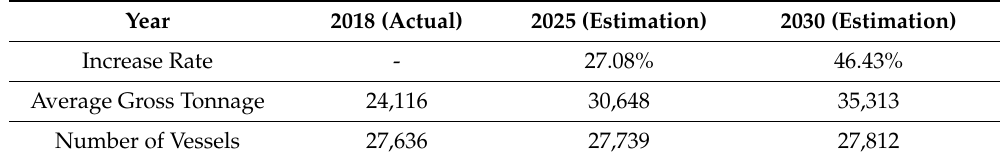
Table 7. Ship Size Increase Rate in Busan Port.